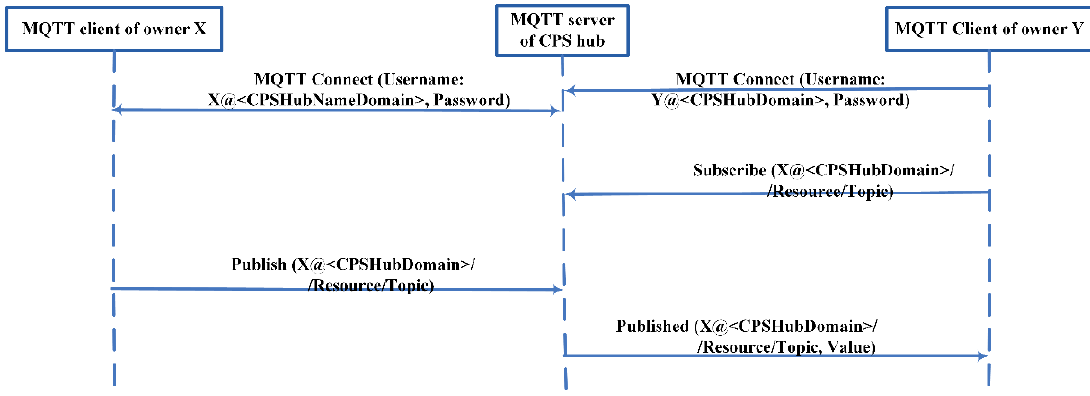
Figure 15. Information sharing using the publish / subscribe service of the CPS